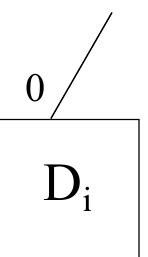
Figure 3. A generic device layout within the framework